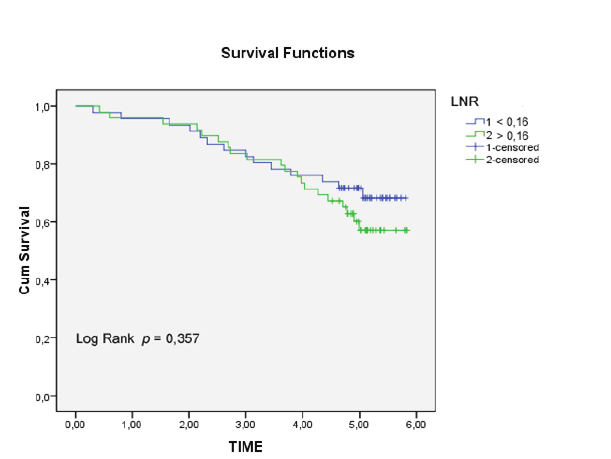
Figure 2b: Overall survival (OS) according to circulating CEA (< 3.5ng/ml vs ≥ 3.5ng/ml, p = 0.001